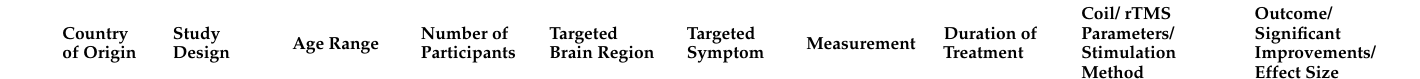
Table 2. Summary of studies using rTMS for the treatment of TRD.